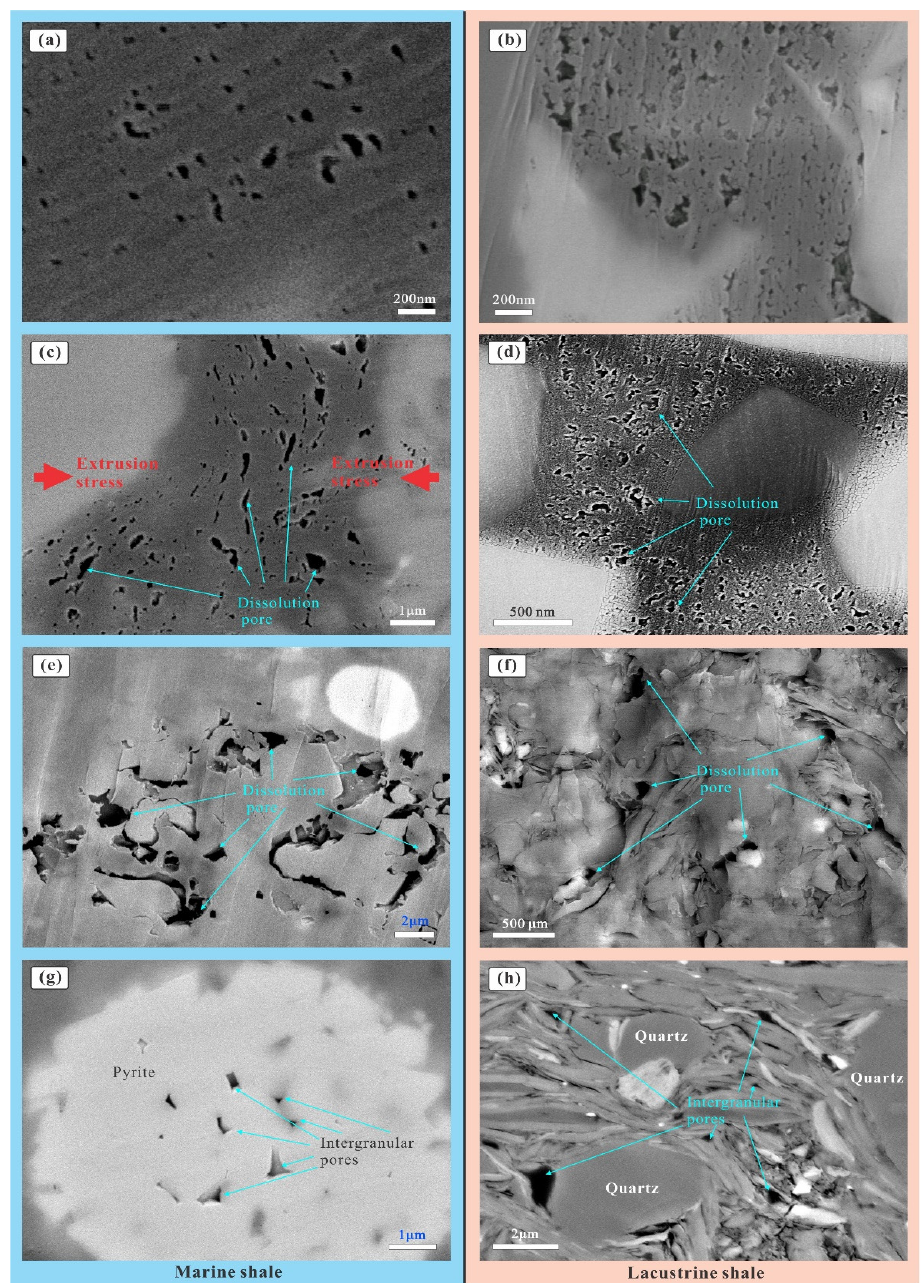
Figure 4. The pore morphological characteristics in the FE-SEM images. ( a ) The OM pores in the marine shale. ( b ) The OM pores in the lacustrine shale. ( c ) The dissolution pores in the organic matter are deformed by the extrusion stress in the marine shale. ( d ) Part of the OM pores were dissolved in the lacustrine shale. ( e ) The dissolution pores in the marine shale are partly connected with each other by the micro-fractures. ( f ) The dissolution pores in the lacustrine shale are isolated from each other. ( g ) In marine shale, the intergranular pores in the clusters of pyrite crystals. ( h ) The lacustrine shale; the intergranular pores are commonly observed between the mineral